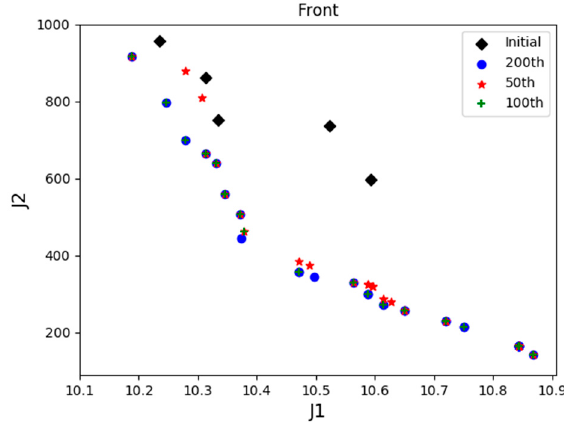
Figure 13. The best frontier distribution in history in Scenario 2.